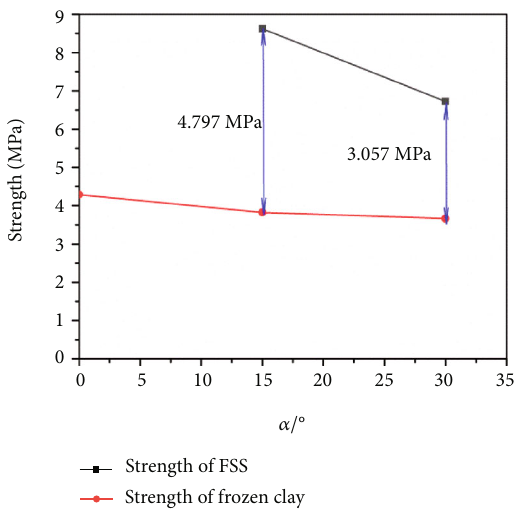
Figure 13: Strength variations of the FSS and frozen clay with di ff erent principal stress